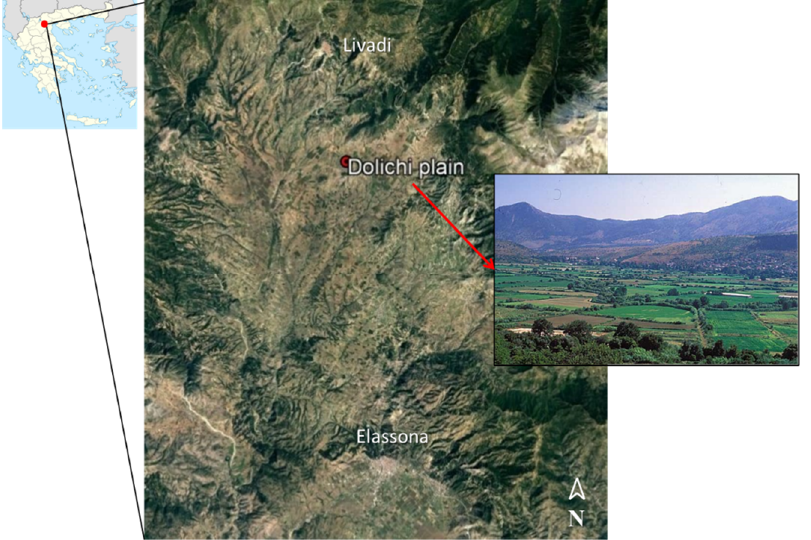
Figure 1. Map of Dolichi plain in the area of Elassona (study area). Image and photo sources: The blank map of Greece (on the top left) is by Lencer, CC BY-SA 3.0, https://commons.wikimedia.org/w/index.php?curid=4432468. The satellite map image is extracted and edited from Google Earth (https://earth.google.com/) on 22 November 2017. The landscape photo of the Dolichi plain is taken from [38].